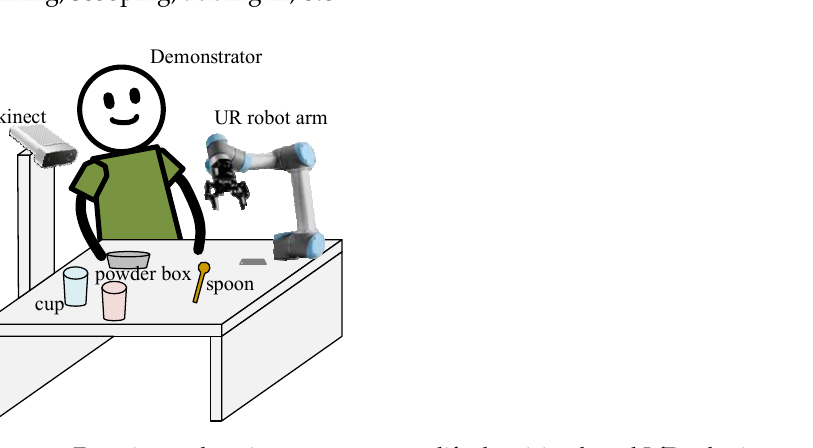
Figure 1. Experimental environment to exemplify the vision-based LfD robotic system.